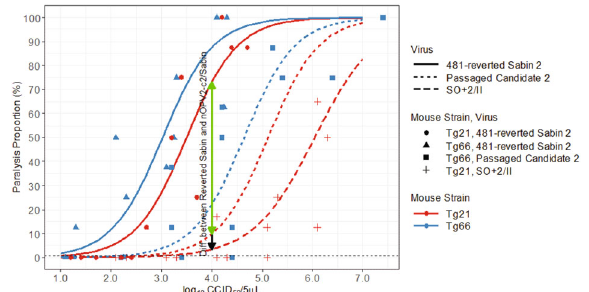
Fig. 3 Selection of dose level of inoculum used in the modi fi ed mouse neurovirulence test. Estimated/predicted probability of mouse paralysis (y-axis) as a function of inoculum ( x -axis), virus (dashed versus solid lines), and mouse strain (Tg21 versus Tg66), shown overlaid on data used to fi t the logistic regression model. Model fi t to data with Tg66 mice (passaged nOPV2-c2 and 481- reverted Sabin 2) and with Tg21 mice (481-reverted Sabin 2 only), and used to predict curve for Tg21 mice with passaged nOPV2-c2 inoculum. Vertical lines and associated annotations denote the difference in estimated paralysis rate between passaged nOPV2-c2 and 481-reverted Sabin 2 (solid green), and also between non- reverted Sabin 2 (SO + 2/II) and a 481-reverted Sabin 2 (solid green + solid black extension) in Tg21 strain mice at the nominal inoculum selected (4.0 log 10 CCID 50 /5 µl) to enable differentiation of paralysis rates.